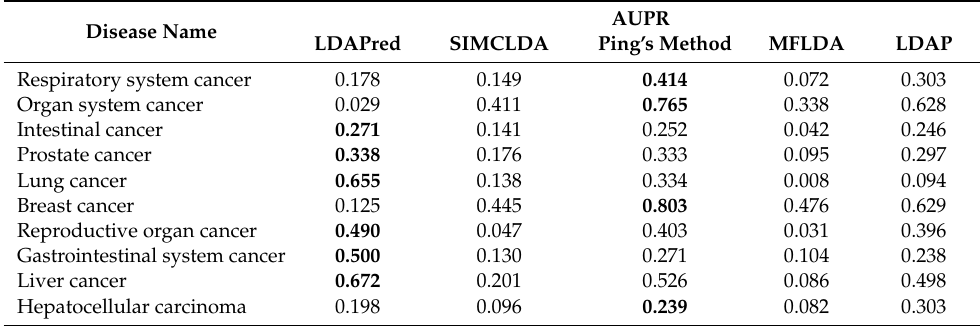
Table 2. Area under PR curves (AUPR) of LDAPred and other methods for all diseases and 10 well-characterized diseases.